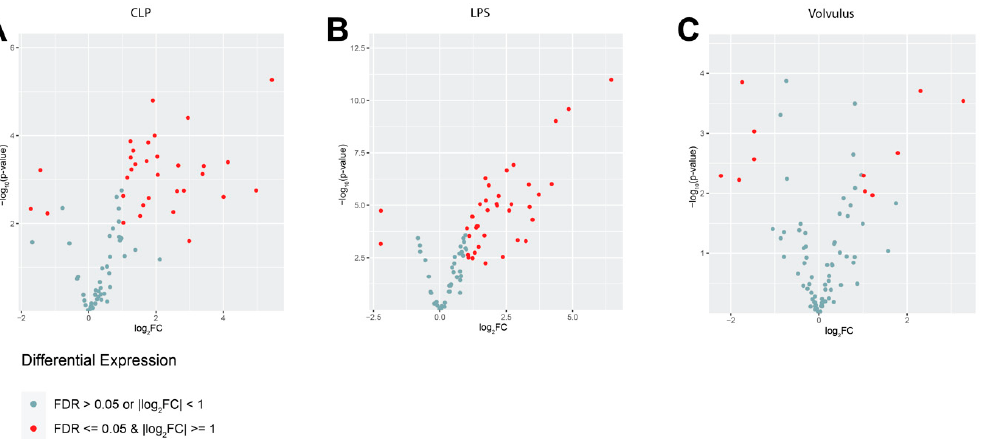
Figure 5. All three models of septic conditions display differential expression of plasma proteins when compared with the controls at 48 h. ( A ) CLP resulted in upregulation of 29 and downregulation of 3 proteins. ( B ) LPS treatment led to upregulation of 37 and downregulation of 2 proteins. ( C ) Midgut volvulus resulted in upregulation of 6 and downregulation of 5 proteins. Expression was defined as significantly different if FDR ≤ 0.05 and |log2FC| ≥ 1 was met. All differentially regulated plasma proteins are listed in supplement I and